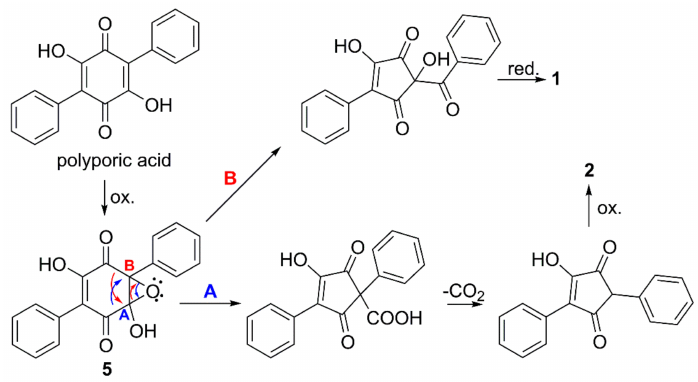
Figure 3. Proposed formation of compounds 1 and 2 from polyporic acid, via the monooxygenase generated intermediate 5 , and followed by two alternate openings of the epoxide (A and